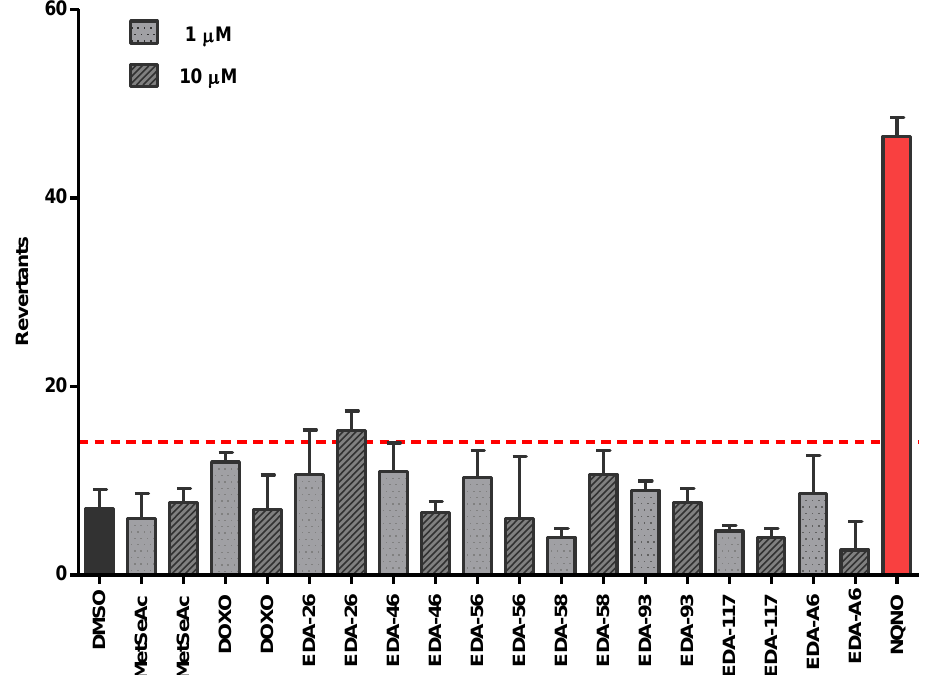
Figure 9. Safety profile (384-well microfluctuation Ames test) for the selenoesters with significant cytostatic activity, DMSO—solvent control. All tested compounds and references were evaluated at 1 and 10 µM concentrations, except for NQNO (0,5 µM); ---- baseline defining the mutagenicity threshold (over this line).